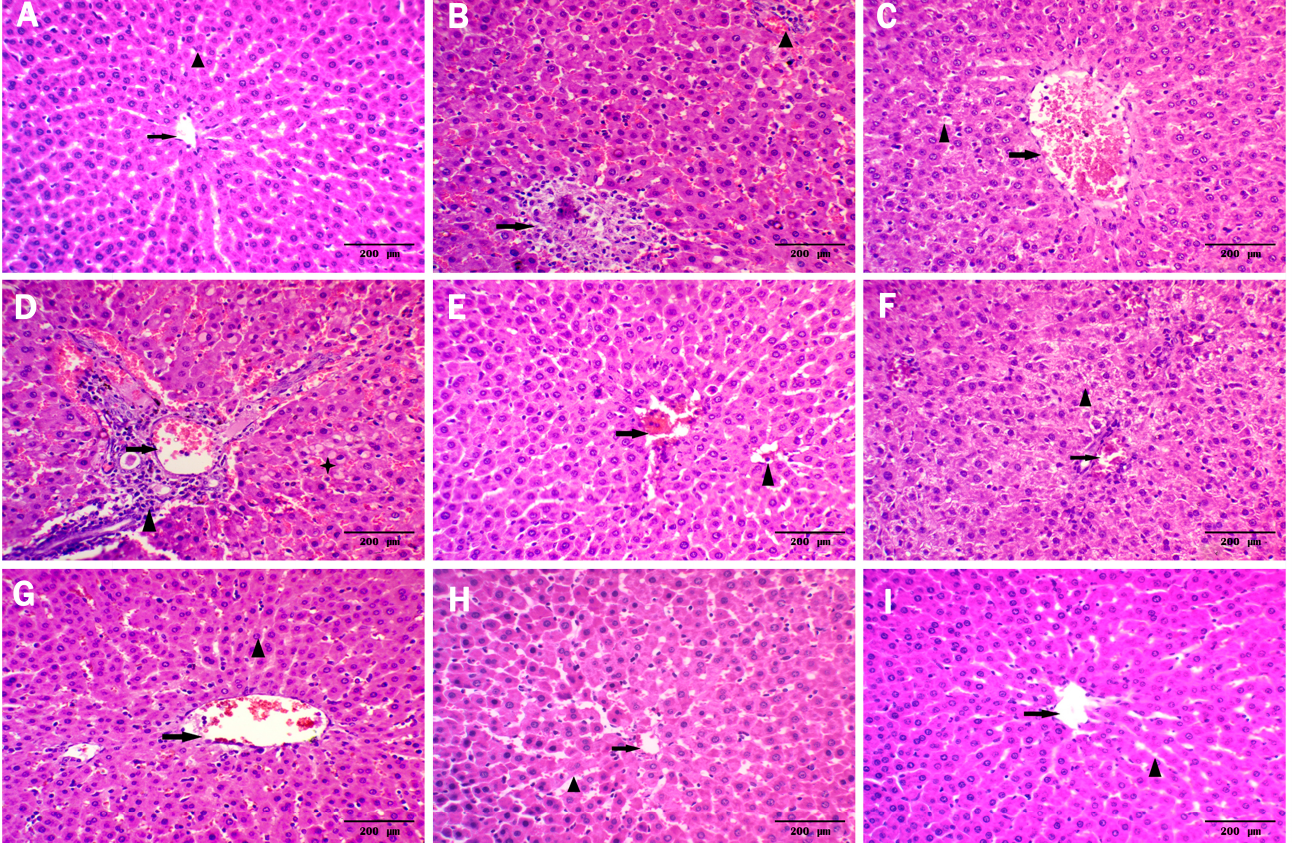
Table 3. Histopathological damage scores for liver tissues following hepatic ischemia reperfusion injury (IRI) of rats after the administration of BBE , AgNPs, 50 BBE ‐ AgNPs, 200 BBE ‐ AgNPs and Silymarin. IRI, ischemia/reperfusion injury; BBE , Blackberry Extract; AgNPs, silver nanoparticles; BBE ‐ AgNPs, Blackberry loaded silver nanoparticles.